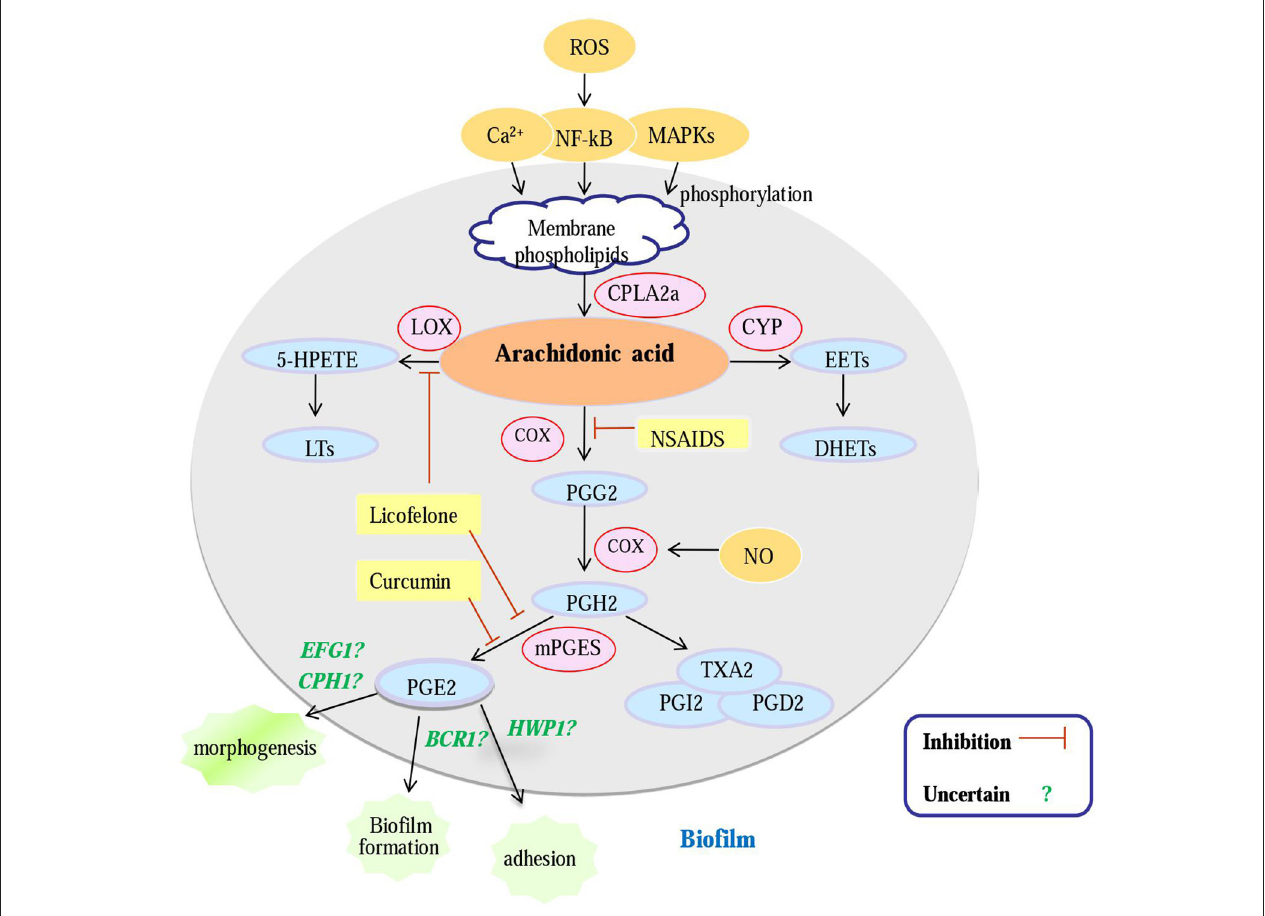
FIGURE 1 | An overview of potential antifungal targets against a Candida biofilm based on an enzyme in the arachidonic acid cascade. Gene (green); enzyme (pink); metabolites (blue); inhibitors (yellow); Question mark: PG E2 can regulate biofilm morphogenesis, biofilm formation and biofilm adherence, whether PGE2 modulates biofilm formation of C. albicans by regulating these genes is uncertain; cPLA2a, cytosolic PLA2a; CYP, cytochrome P450; LOX, lipoxygenase; COX, cyclooxygenase; mPGES, microsomal; prostaglandin E2 synthase; NSAIDS, Non-Steroidal Antiinflammatory Drugs; PGG2, prostaglandin G2; PGH2, prostaglandin H2; PGE2, prostaglandin E2; NO, nitric oxide.